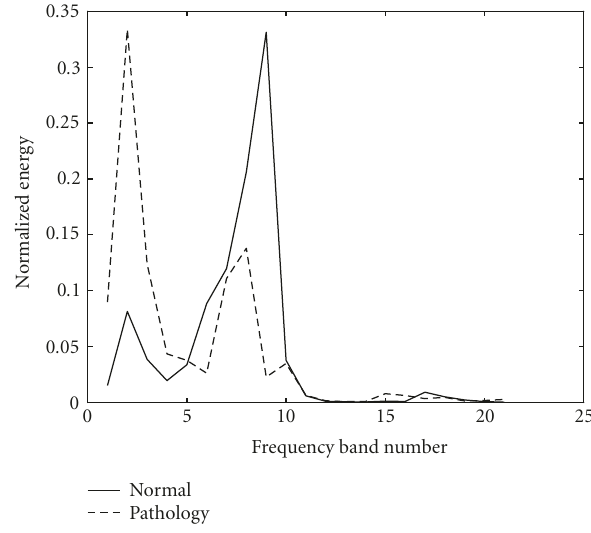
Figure 3: Normalized energy spectrum for normal and pathologic voice